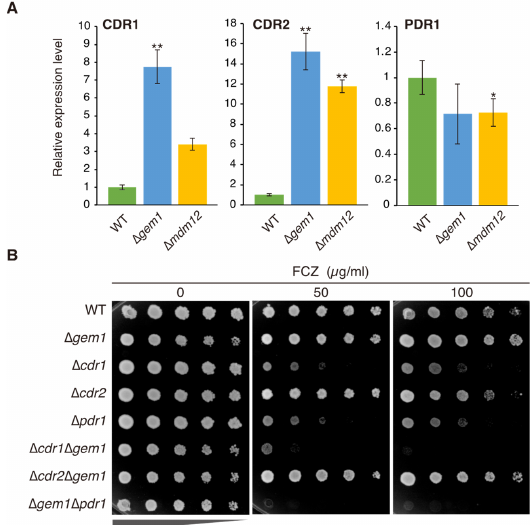
Figure 3. Involvement of CDR genes in fluconazole resistance in ∆ gem1 cells. ( A ) Quantitative RT ‐ PCR for CDR1 , CDR2 , and PDR1 in wild ‐ type, ∆ gem1 , and ∆ mdm12 cells. The cells were exponentially incubated at 37 °C in minimal SD medium. Data were normalized to the corresponding levels of the housekeeping transcript ( TEF1 ), and the expression levels of WT were set at a relative expression of 1. Values are presented as the mean ± standard error of 3 independent experiments. ( B ) Growth of PDR gene mutants in fluconazole medium. Indicated cells were spotted in 4 ‐ fold serial dilutions, as indicated by triangles, on agar plates of minimal SD medium containing fluconazole at the indicated concentrations . The cells were incubated at 37 °C in minimal SD medium for 3 days. p ‐ values of the t ‐ test vs. wild ‐ type are as follows: * p < 0.05, ** p < 0.01.